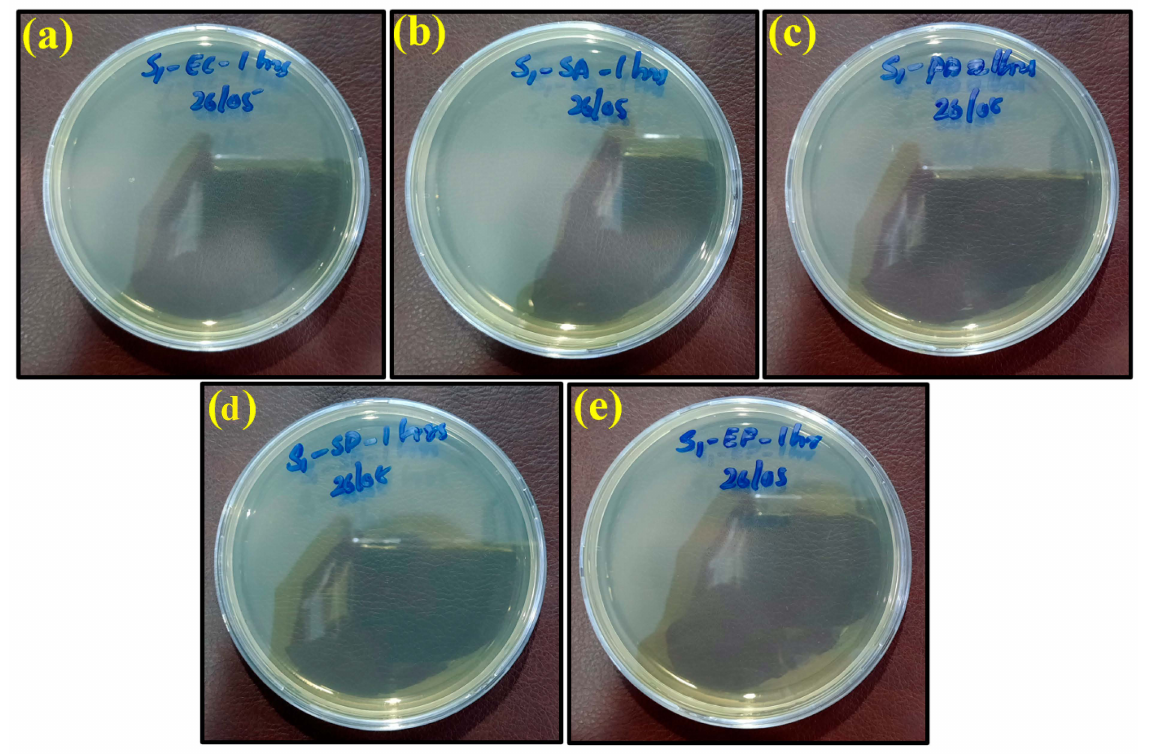
Int. J. Mol. Sci. 2022 , 23 , x FOR PEER REVIEW Figure 7. Images of remaining bacteria on PLA/copper sheet after cultivation for 1 h: ( a ) E. coli ; ( b ) S. aureus ; ( c ) P. aeruginosa ; ( d ) S. Poona; ( e ) Enterococci .